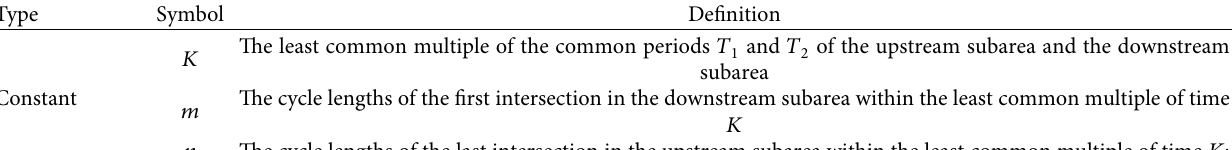
Table 2: Symbolic definition of decision variables and constant.